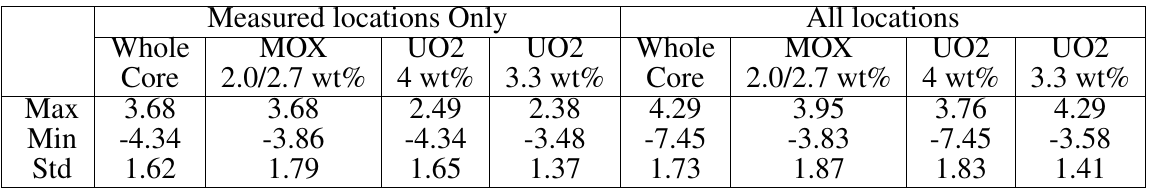
Table I: VENUS-2 Measured vs. predicted pin-wise fission reaction rates in % Measured locations Only All